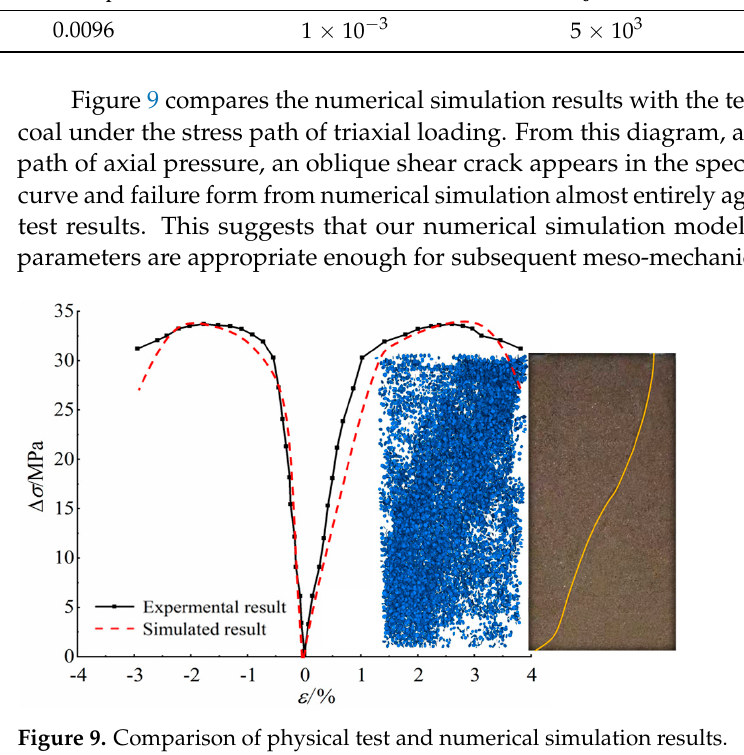
Figure 9. Comparison of physical test and numerical simulation results.